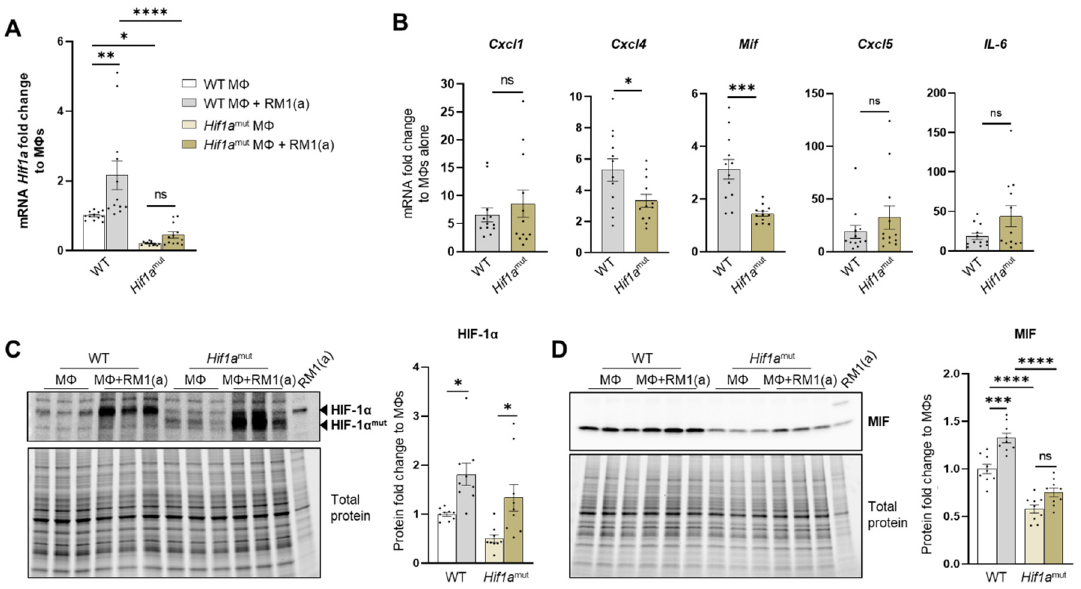
Figure 5. HIF-1 α depletion in efferocytic BM macrophages reduces MIF expression. ( A ) Hif1a mRNA expression levels in Hif1a flox/flox (WT) and Hif1a mut BM macrophages (M Φ ). ( B ) mRNA from efferocytic and control BM macrophages from Hif1a flox/flox and Hif1a mut mice were analyzed by RT-qPCR for the specified inflammatory cytokine genes ( n = 12). ( C , D ) Protein lysates from efferocytic and control BM macrophages from Hif1a flox/flox (WT) and Hif1a mut mice were analyzed by Western blot with HIF-1 α and MIF antibodies ( n = 9). The Western blots shown in ( C , D ) are representative images. Fold change was calculated relative to WT non-efferocytic BM macrophages ( A , C , D ) or to its own non-efferocytic BM macrophage control ( B ). Plotted data are shown as mean ± SEM. * p < 0.05, ** p < 0.01, *** p < 0.001, **** p < 0.0001, ns = not significant (ordinary one-way ANOVA; Tukey’s multiple comparison test and unpaired t -test). Additional results are shown in Appendix A—Figures A6–A8.